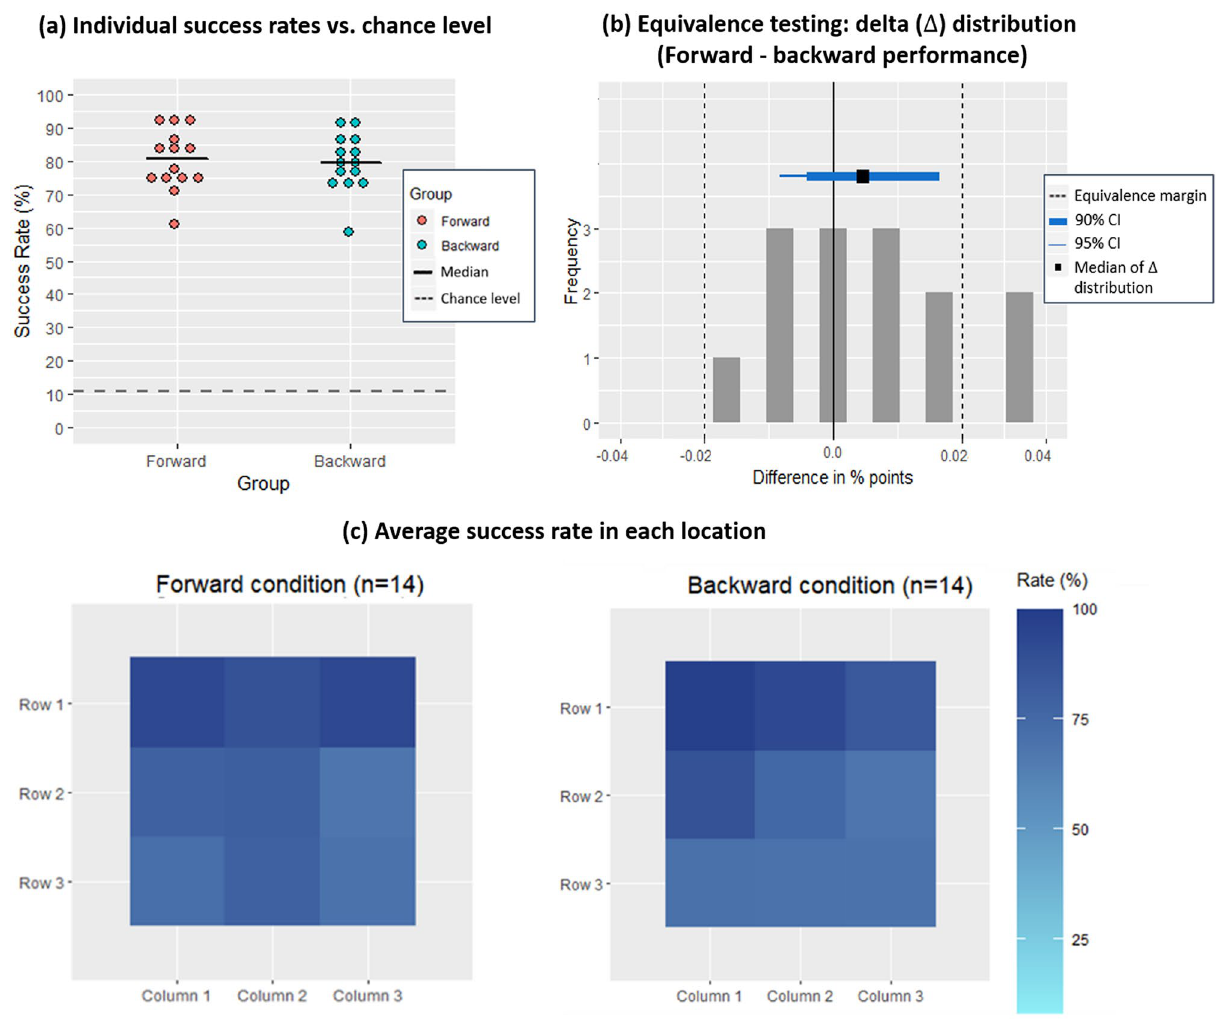
Figure 3. ( a ) Individual average success rates in the forward vs. backward conditions: individual average success rates plotted against chance level (11%) in forward (pink) and backward (turquoise) conditions. Each colored dot represents the average success rate of one participant. Chance level is represented by the dashed gray line. All participants in both groups performed well above the chance level. The median of each group is represented by a solid black line. The two individual accuracy distributions closely resemble each other, further suggesting entirely comparable performance in the forward vs. backward fields. ( b ) Equivalence testing using the delta ( (cid:31) ) distribution (forward–backward performance). The grey columns represent the frequency of values of the delta distribution (i.e., the difference in percentage points between forward and backward performances). The dashed black lines represent the upper and lower equivalence bounds (� L = − 0.024 and � U = 0.024 ) . The thick blue line represents the 90% confidence interval (CI) of the (cid:31) distribution [− 0.005, 0.02]. The thin blue line represents the 95% CI of the (cid:31) distribution [− 0.01, 0.02]. The black square represents the median of the (cid:31) distribution (M = 0.0055). As we can observe, both the 90% and the 95% CIs include the value of 0, but do not include the equivalence boundaries. Thus, we can conclude that the difference between success rates distributions of the forward and backward conditions is not statistically significant and the distributions are statistically equivalent. ( c ) Heat maps for the average success rate in each of the nine cells across participants. Bottom left: blindfolded sighted participants in the forward condition (n = 14). Bottom right: blindfolded sighted participants in the backward condition (n = 14). In both panels, each cell on the 3 × 3 grid is color-coded based on the average success rate in it. Darker shades of blue represent higher success rates. Accuracy was very high for both groups of participants in all cells. This Figure was created using R Core Team (2018). R: A language and environment for statistical computing. R Foundation for Statistical Computing, Vienna, Austria. R version